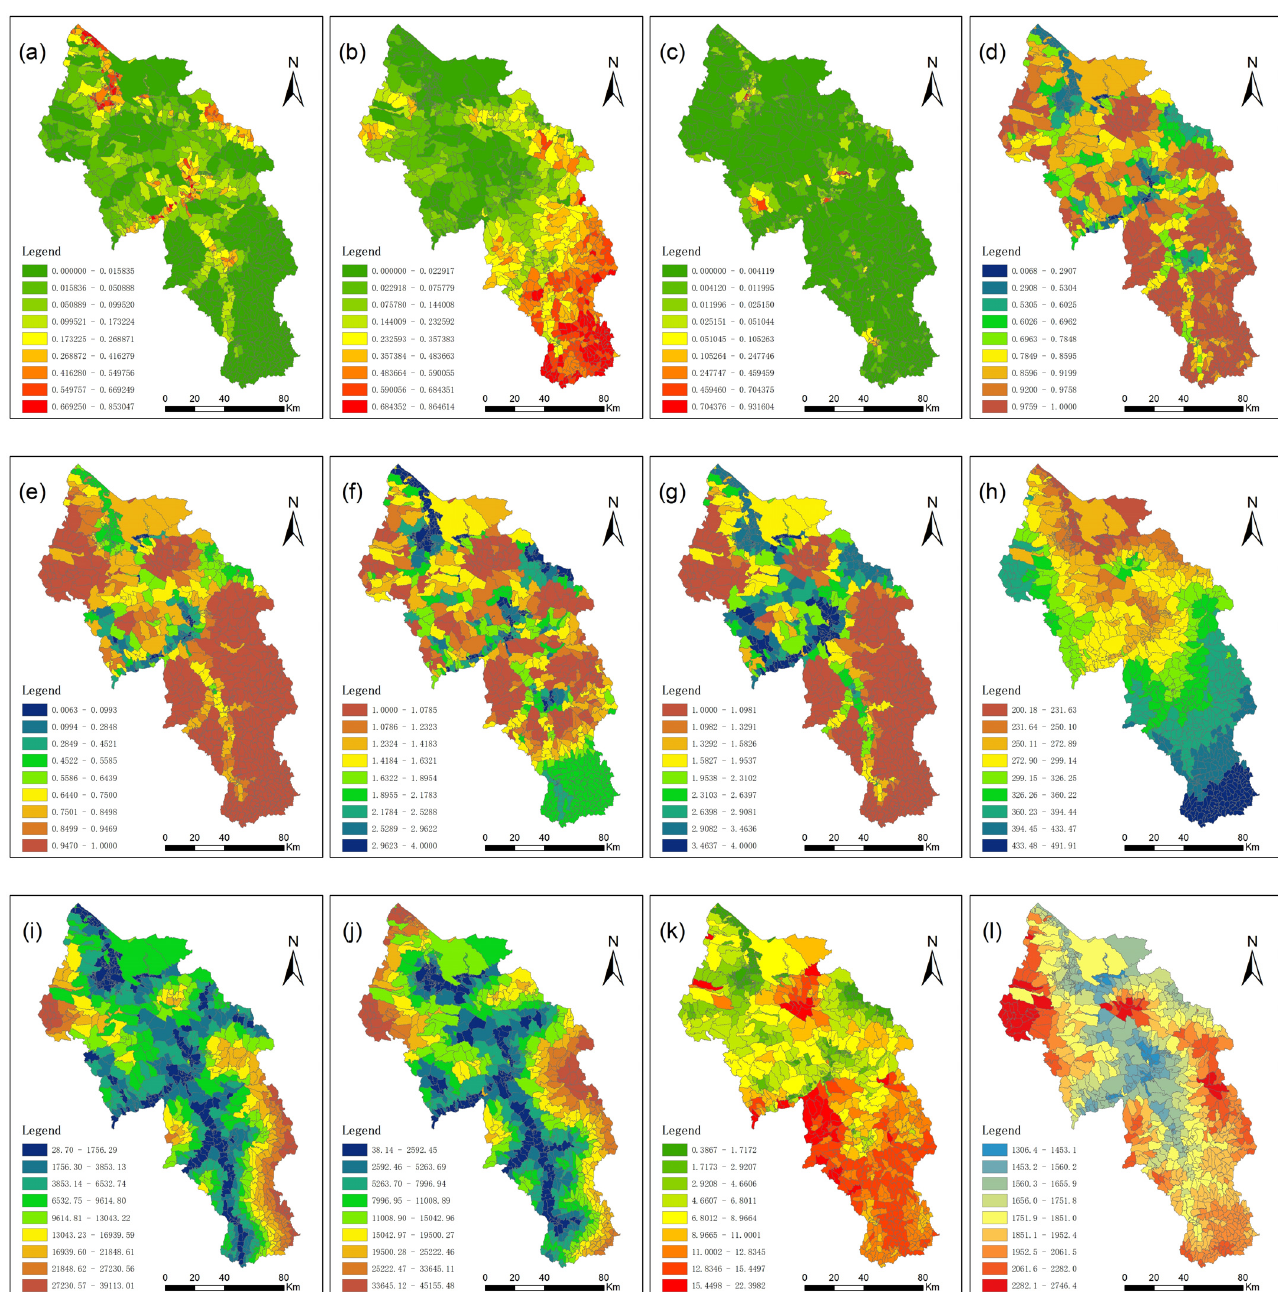
Figure 9. ( a ) Irrigated farmland density; ( b ) non-irrigated farmland density; ( c ) construction land density; ( d ) CIA; ( e ) CIU; ( f ) WRSA, assign values 1–4 for the four suitability grades; ( g ) WRSU, assign values 1–4 for the four suitability grades; ( h ) precipitation; ( i ) distance to irrigation water supply source; ( j ) distance to urban water supply source; ( k ) slope; ( l ) elevation.